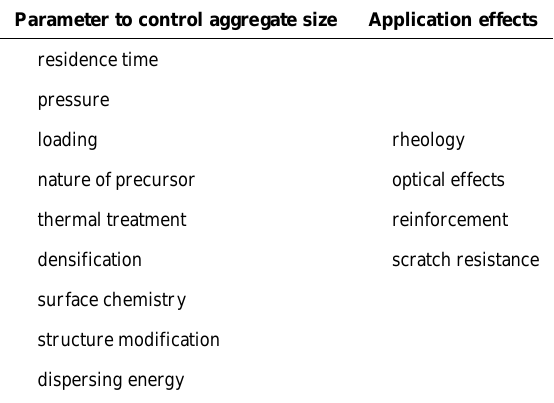
Table 2 Morphology control parameters and resultant effects in the